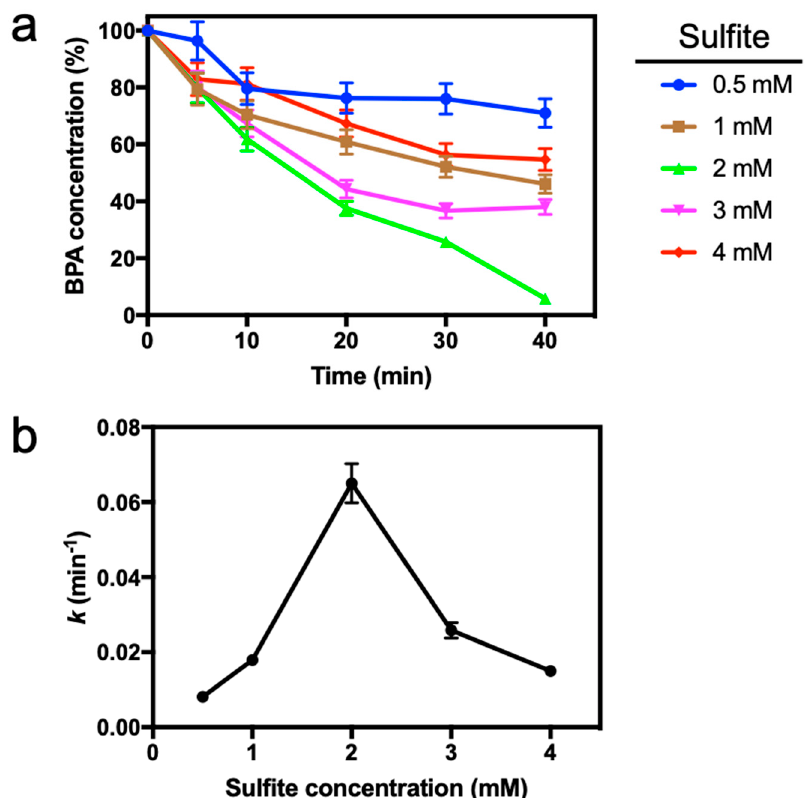
Figure 4. E ff ect of sulfite dose on the BPA removal by the electro / Mn(II) / sulfite process. ( a ) BPA removal and ( b ) pseudo first-order removal constant versus sulfite concentration. Reaction conditions: 0.2 mM Mn(II), 0.5–4 mM sulfite, 5 mM sulfate as supporting electrolyte, 10 µ M BPA, 100 mA electric current, and pH 6.